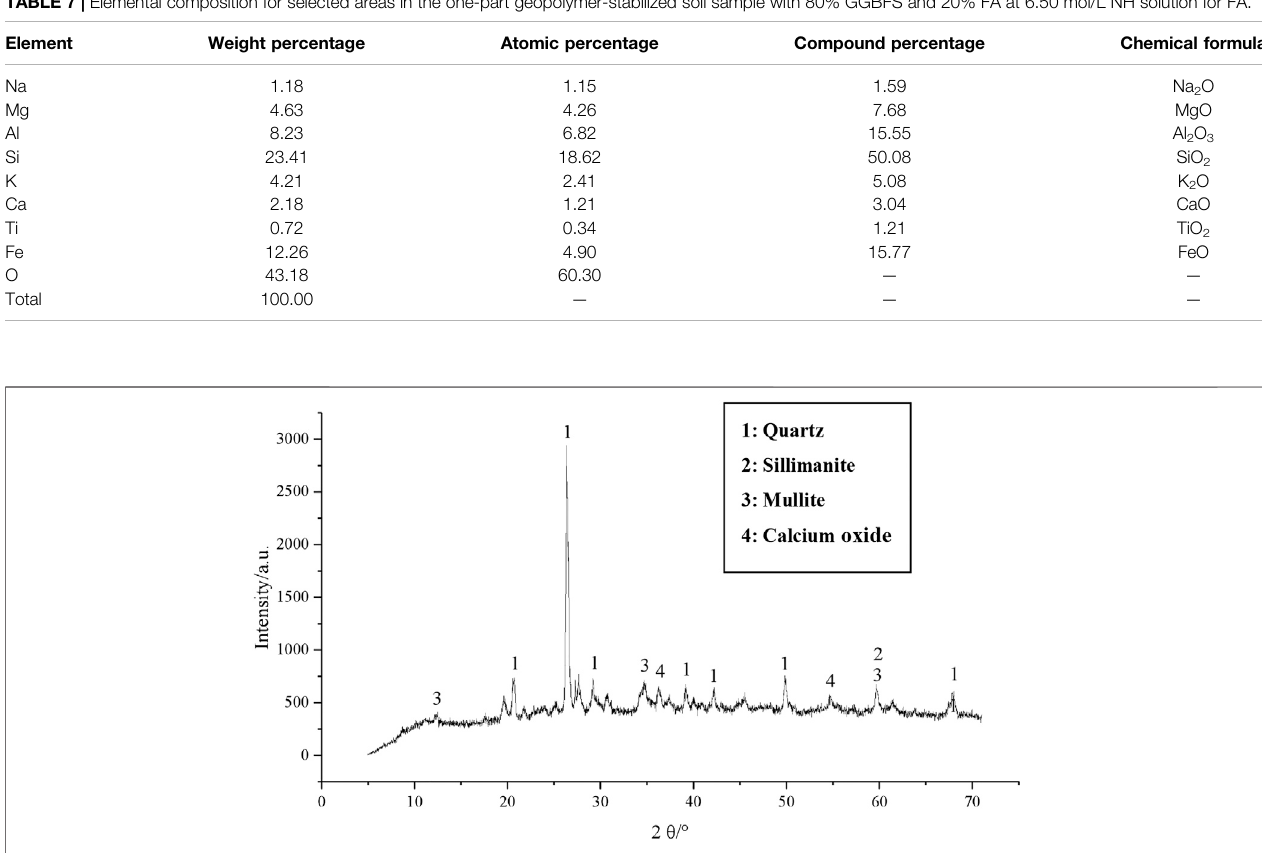
FIGURE 15 | XRD pattern of the one-part geopolymer-stabilized soft clay with 100% GGBFS and 0% FA at 5.42 mol/L NH solution for 14 days.